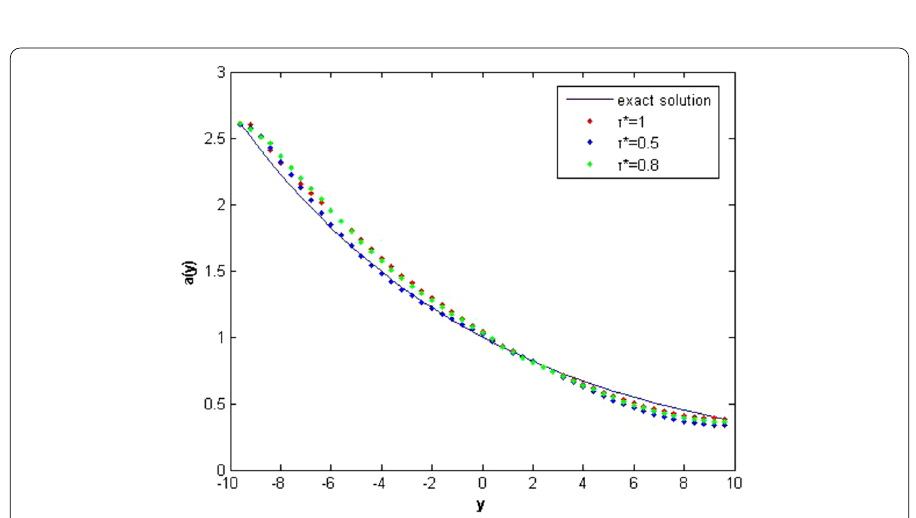
Figure 6 Identified drifts with the noisy level 0.01 for Example